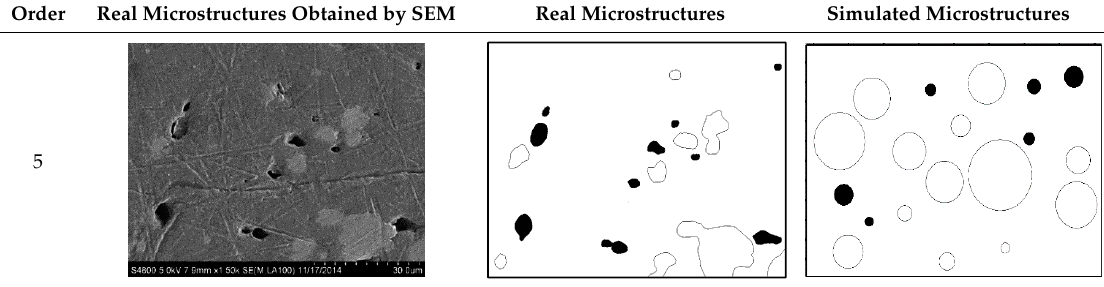
Figure 2. Distribution of aluminum particle diameters.